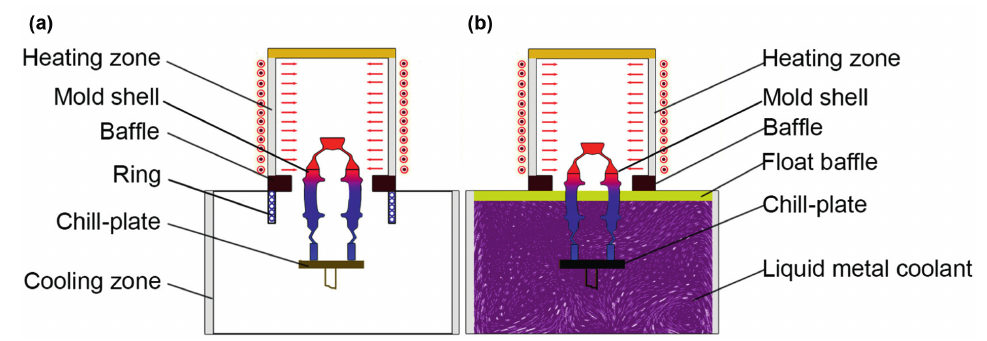
Figure 1: Simplified schematic diagrams for the directional solidification furnaces: (a) HRS and (b)